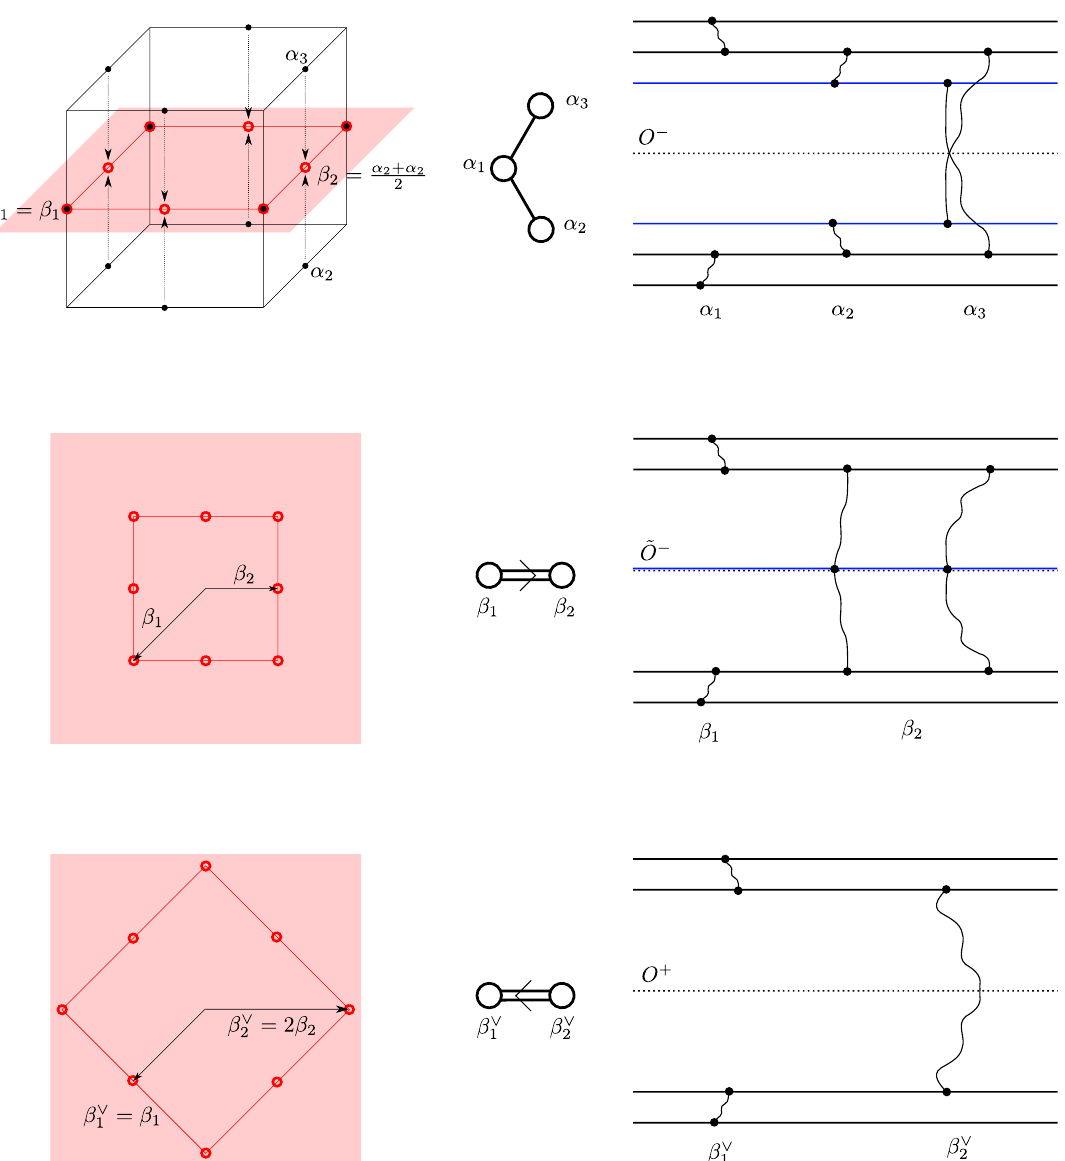
Figure 1 . In the upper-left image, the black dots represent the roots of D 3 , and (cid:11) 1 , (cid:11) 2 and (cid:11) 3 are the simple roots. The red plane is the plane (cid:12)xed by the involution P which exchanges (cid:11) 2 and (cid:11) 3 . The red circles represent the projected roots. They form a B 2 system, with simple roots (cid:12) 1 and (cid:12) 2 , represented below. Finally, the doubling of the short roots due to (2.12) leads to the lower part of the (cid:12)gure with the B _ = C 2 root system. On the right are represented the same steps with branes 2 (full lines) and orientifolds (dotted lines). For the conventions used in the names of the orientifolds, see [15]. The black dots represent fundamental strings (wiggly lines) ending on branes. Only strings corresponding to simple roots are represented. The blue branes are those permuted by P . When restricting to the P -invariant con(cid:12)guration, they are replaced by a single brane stuck on the orien- tifold. In the last part, the ~ O (cid:0) thus obtained is replaced by an O + on which strings can not end [16].